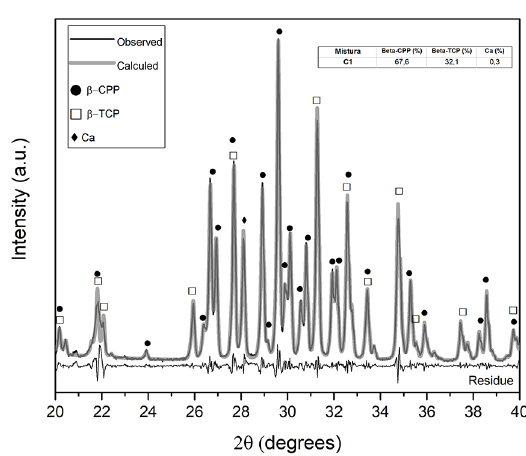
Figure 2. Rietveld analysis pattern for the calcium phosphate